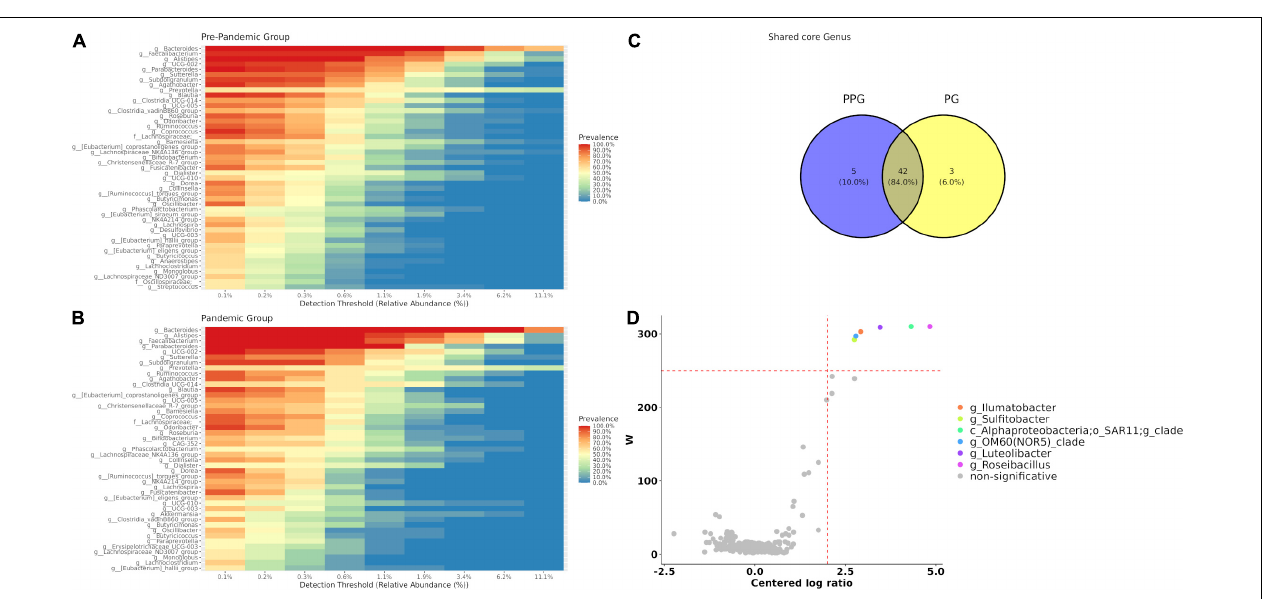
unweighted UniFrac and marginal effects on the weighted UniFrac ( Table 3